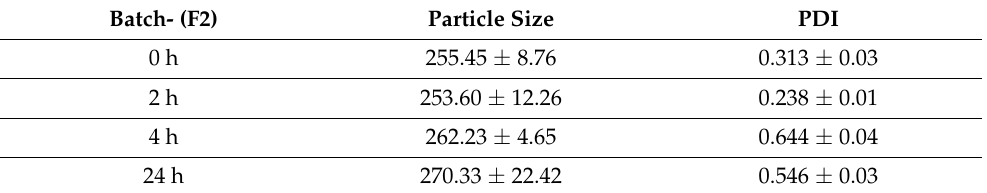
Table 3. Particle sizes of the representative F2 batch after dilution in acidic/gastric solution (pH-1.2) (1 in 1000 dilution) (data are presented as mean ± standard error of mean, where n = 5). Batch- (F2) Particle Size PDI 0 h 255.45 ± 8.76 0.313 ± 0.03 2 h 253.60 ± 12.26 0.238 ± 0.01 4 h 262.23 ± 4.65 0.644 ± 0.04 24 h 270.33 ± 22.42 0.546 ± 0.03